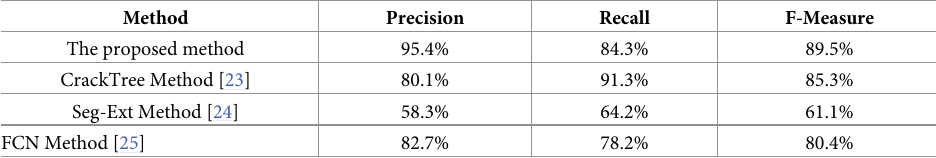
Table 1. Crack growth experiment results for three